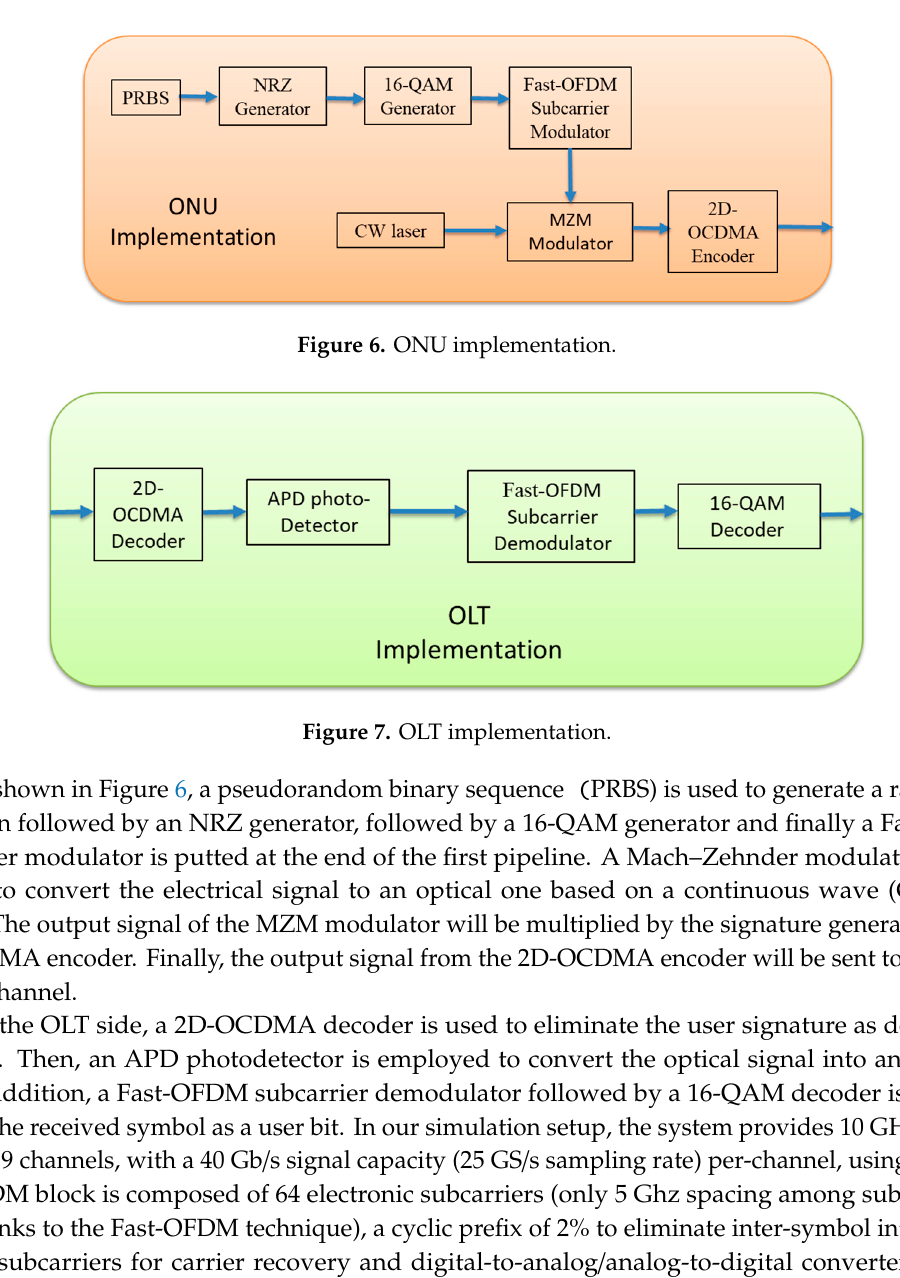
Figure 6. ONU implementation.